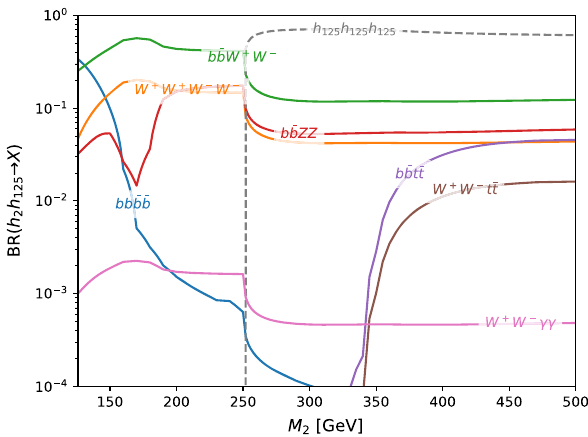
h 125 h 2 (right panel). The shaded regions are excluded by boundedness from below, perturbative unitarity, and searches for heavy scalar reso- nances in diboson final states [121,122]